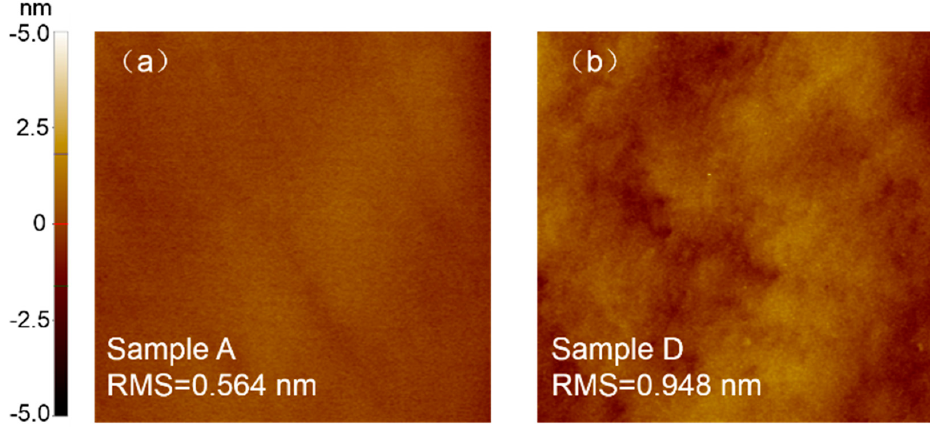
Figure 3. Ohmic contact resistance ( R C ) values of sample A and sample D. The inset shows a linear fit of total resistances of the TLM.